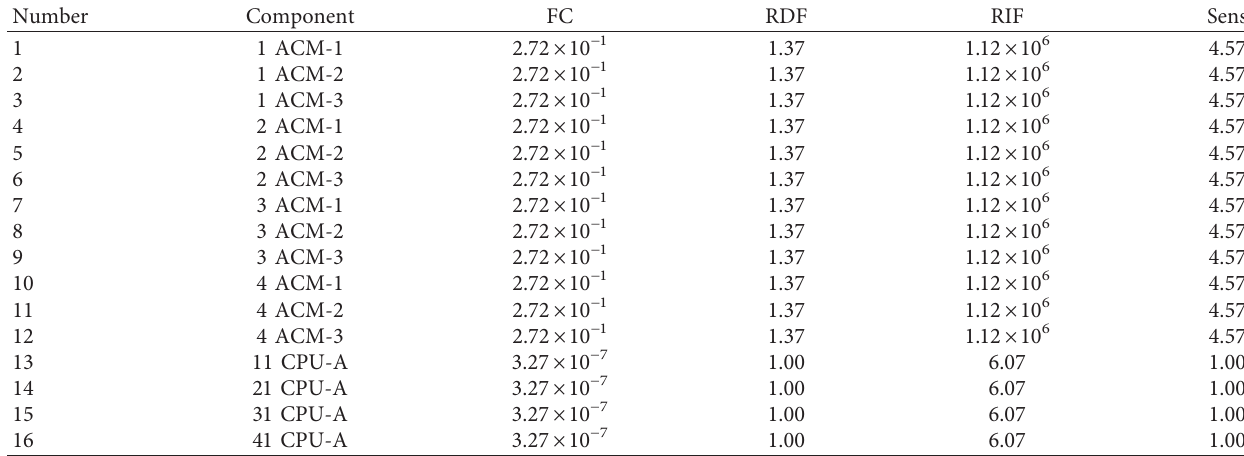
Table 7: Importance and sensitivity of the selected components on system risk.